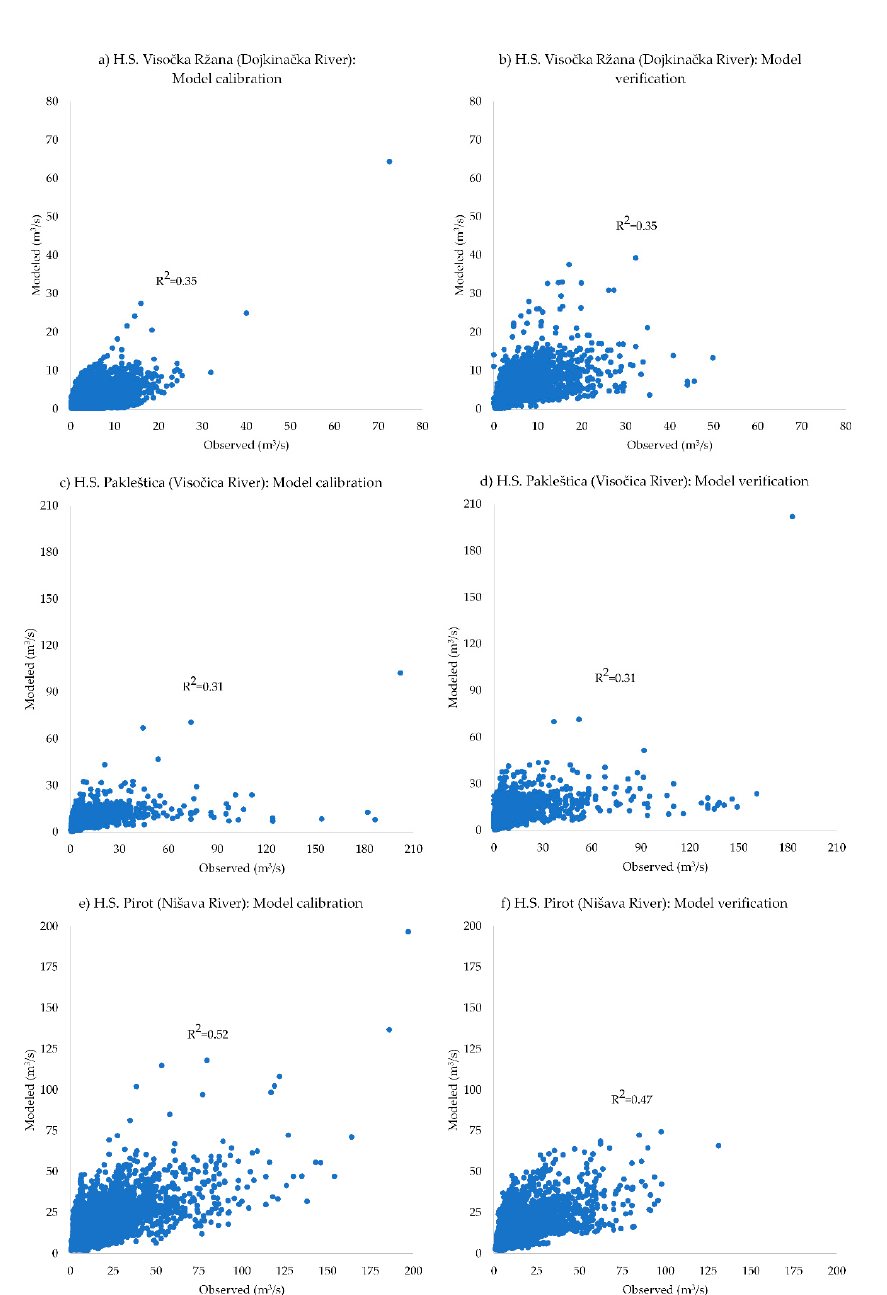
Figure 4. Hydrological model results at the Nišava river basin for the calibration and verification phases.